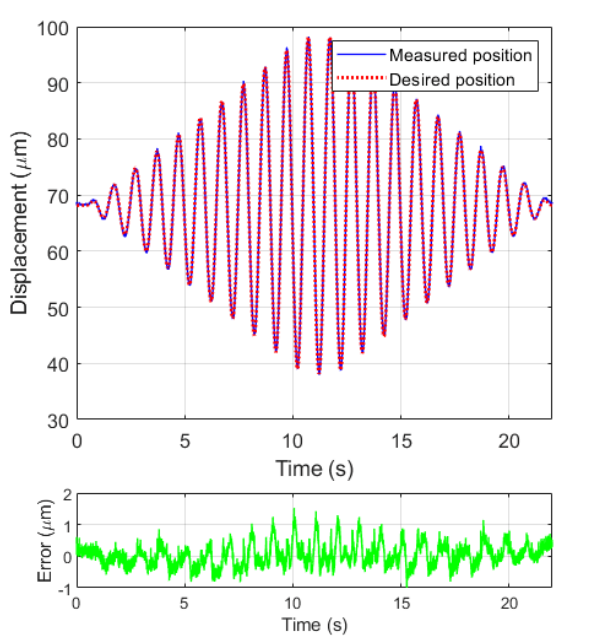
Figure 10. Compensation results at a changing amplitude sinusoidal